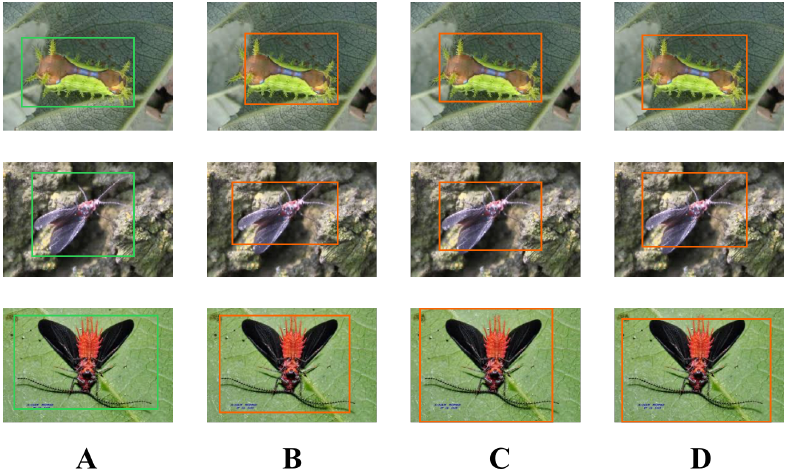
Figure 7. The detection results of our model. ( A ) is the groundtruth; ( B ) is the inc-YOLO; ( C ) is the cluster-RCNN; ( D ) is the ensembled